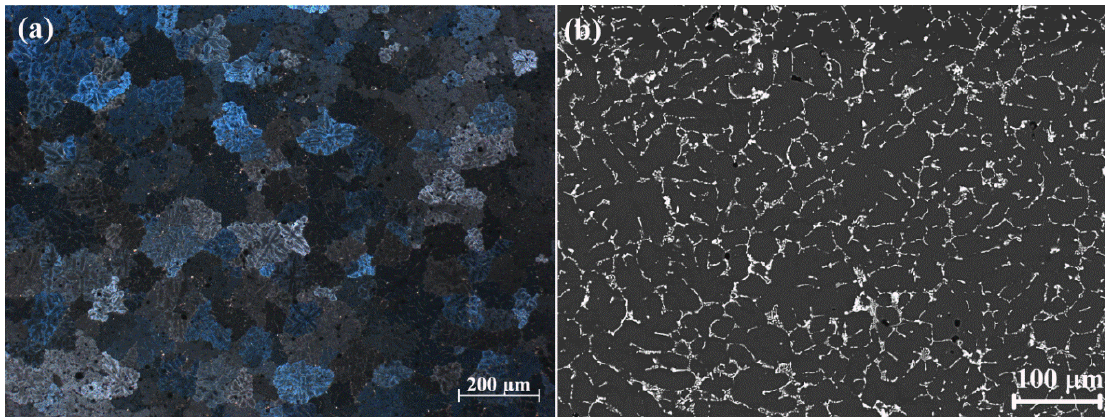
Table 1. Composition of the investigated alloys.